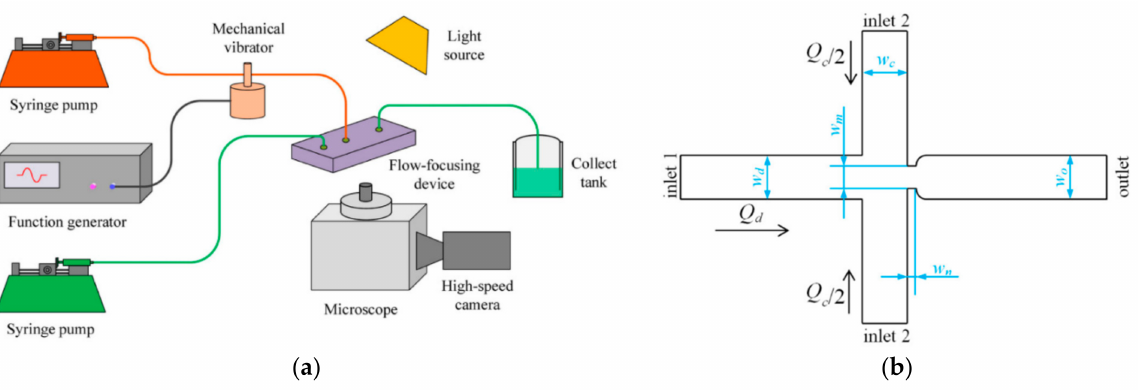
Figure 6. ( a ) Schematic diagram of experimental setup for droplet generation in flow-focusing microfluidic chip with external mechanical vibration. ( b ) Schematic diagram of the flow-focusing microfluidic chip. Reprinted from an open-access source